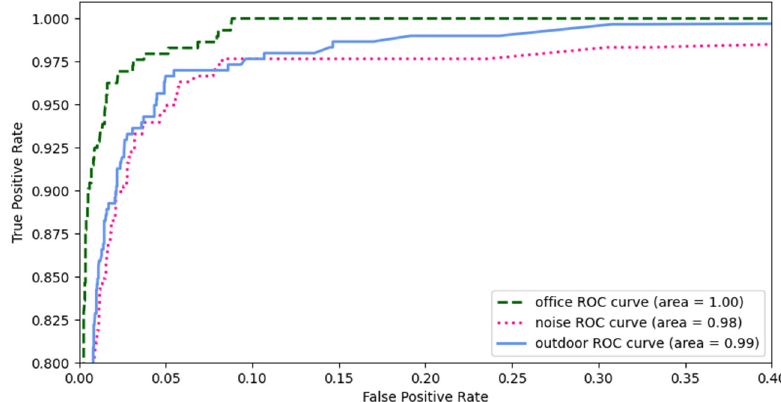
Figure 11. ROC curves of our system under attack.